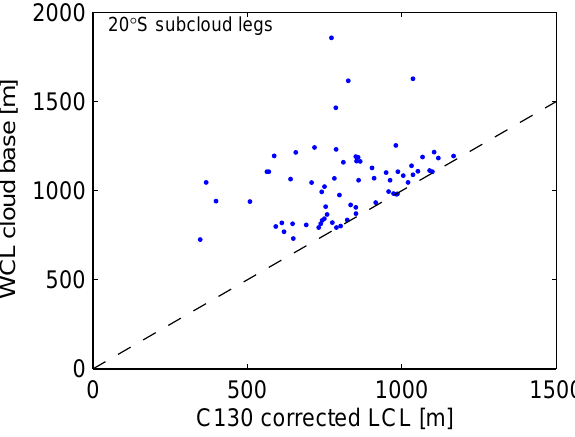
Fig. 13. Scatterplot of WCL cloud base vs. in-situ LCL for 20 ◦ S C130 subcloud legs. Without applying the 0.8K dewpoint correc- tion, the LCL would be increased by approximately 80m, shifting many points well to the right of the dashed 1:1 line which is a lower bound on the physically expected behavior.